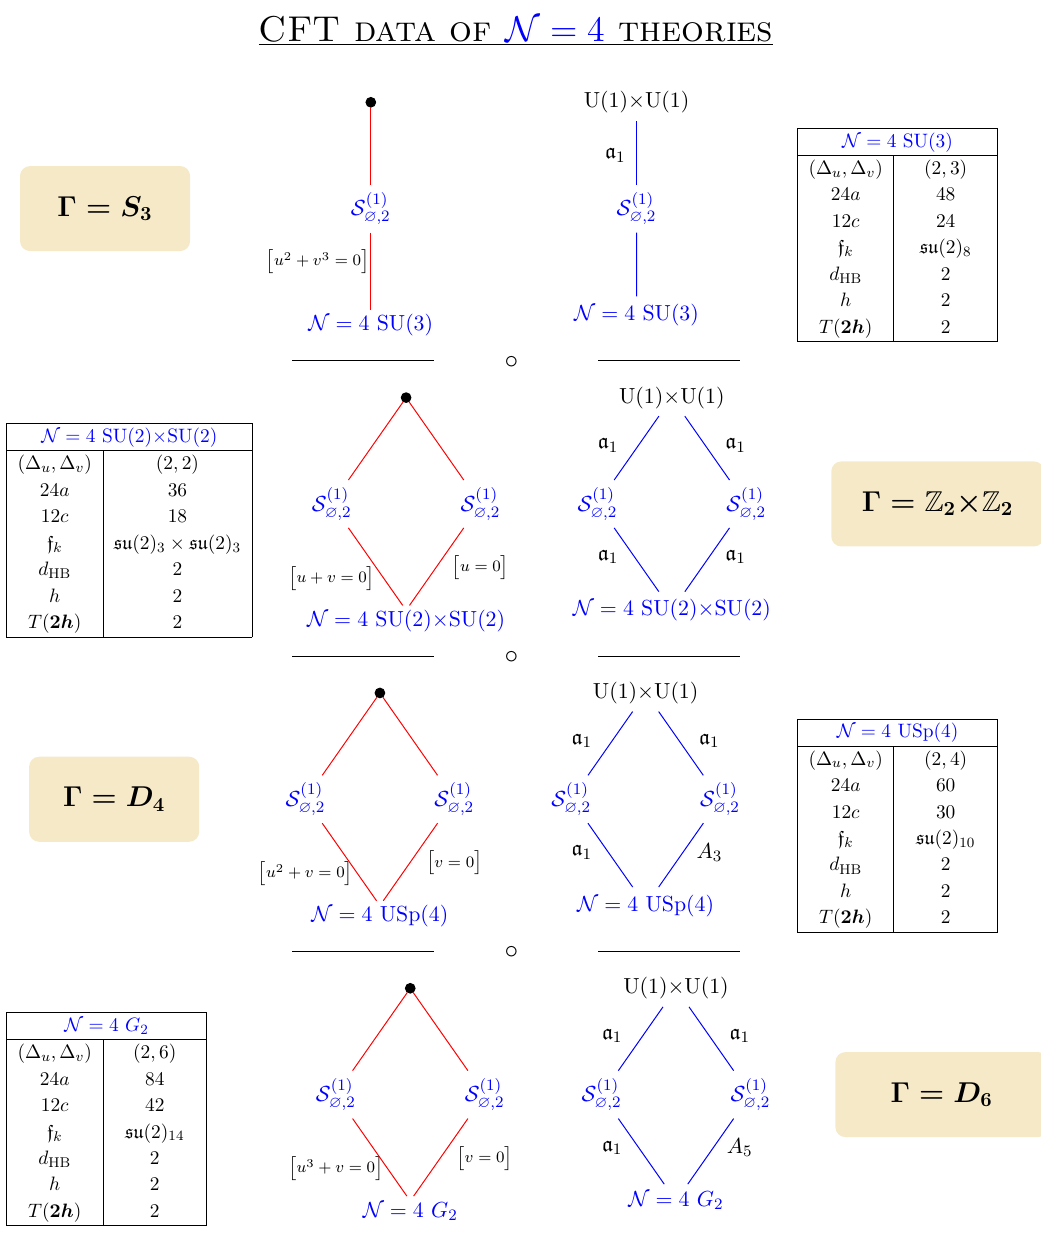
Figure 48. CFT data for N = 4 rank-2